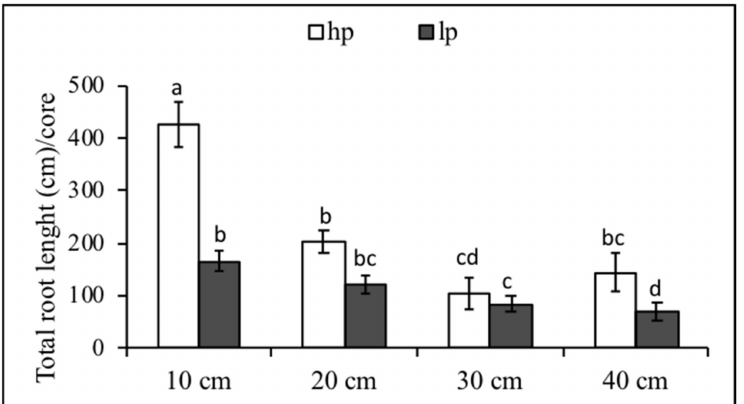
Figure 7. Distribution of root within the soil profile grown under combined water/phosphorus treatments (hp — high phosphorus rate and lp — low phosphorus rate) at Ch ó kw è research station. Values shown are mean ± SE, and the means that share the same letter are not significantly different at α ≤ 0.05. Root core samples were taken 5 cm from the plant stem at 42